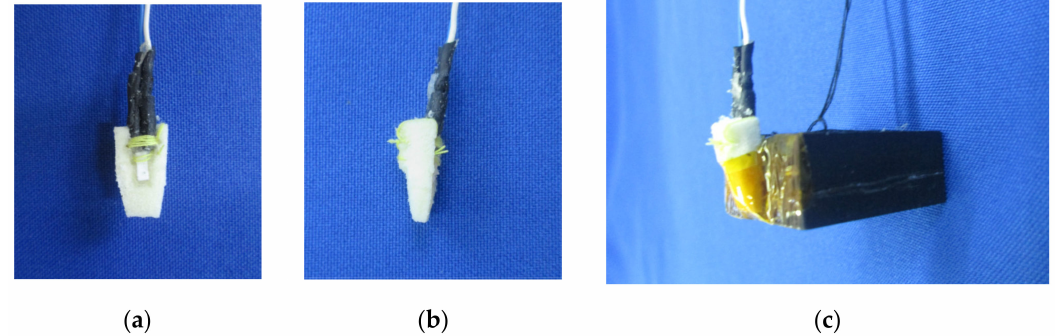
Figure 2. Views of the platinum resistor with the PUR shielding on the frontal ( a ) and lateral ( b ) directions. The assembly of this sensor leans the YBCO bulk lateral surface ( c